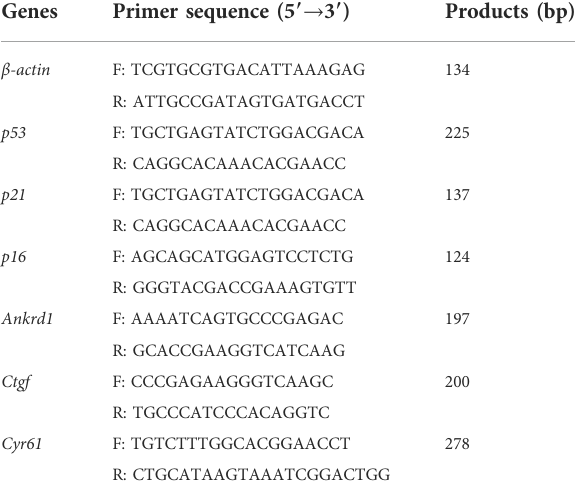
TABLE 1 Primers used for quantitative RT-PCR.